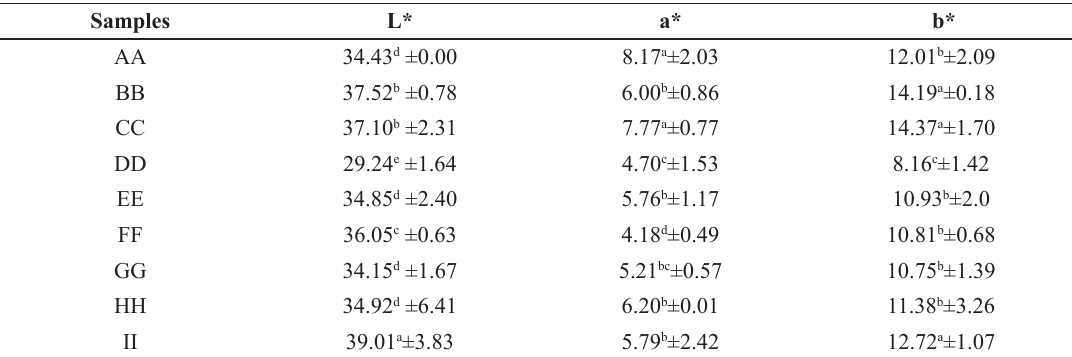
Mean ±SD of three replicates Means in the same row with different superscripts are significantly different (p<0.05). L*,a*,b* means lightness, yellowness and redness respectively